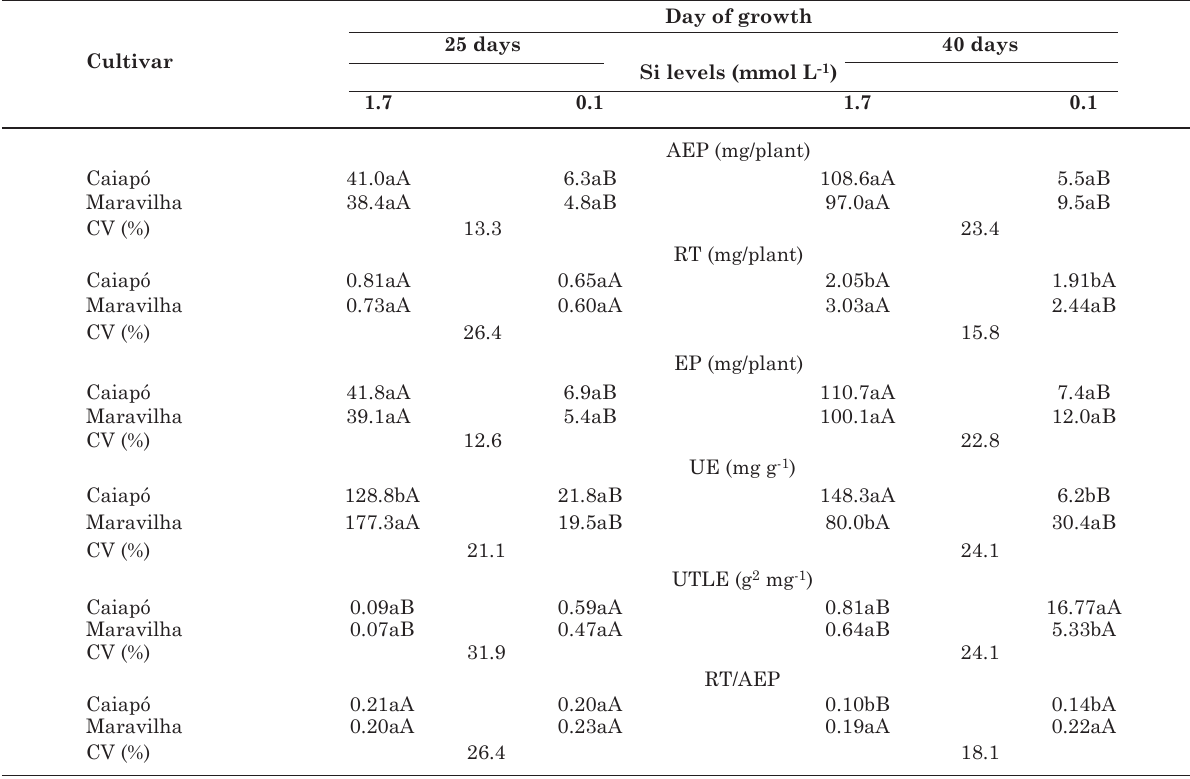
table 4. silicon accumulation in the aerial part (aeP), root (rt), and the entire plant (eP), si uptake effi- ciency: (Ue) = (total si accumulation in the plant/root dry matter yield), utilization efficiency: (Utle) = (total dry matter yield) 2 /(total si accumulation in the plant), and root/aerial part ratio: (rt/aeP) = (root dry matter yield/aerial part dry matter yield) of rice cultivars at different si concentrations in the nutrient solution 25 and 40 days after transfer into the growth